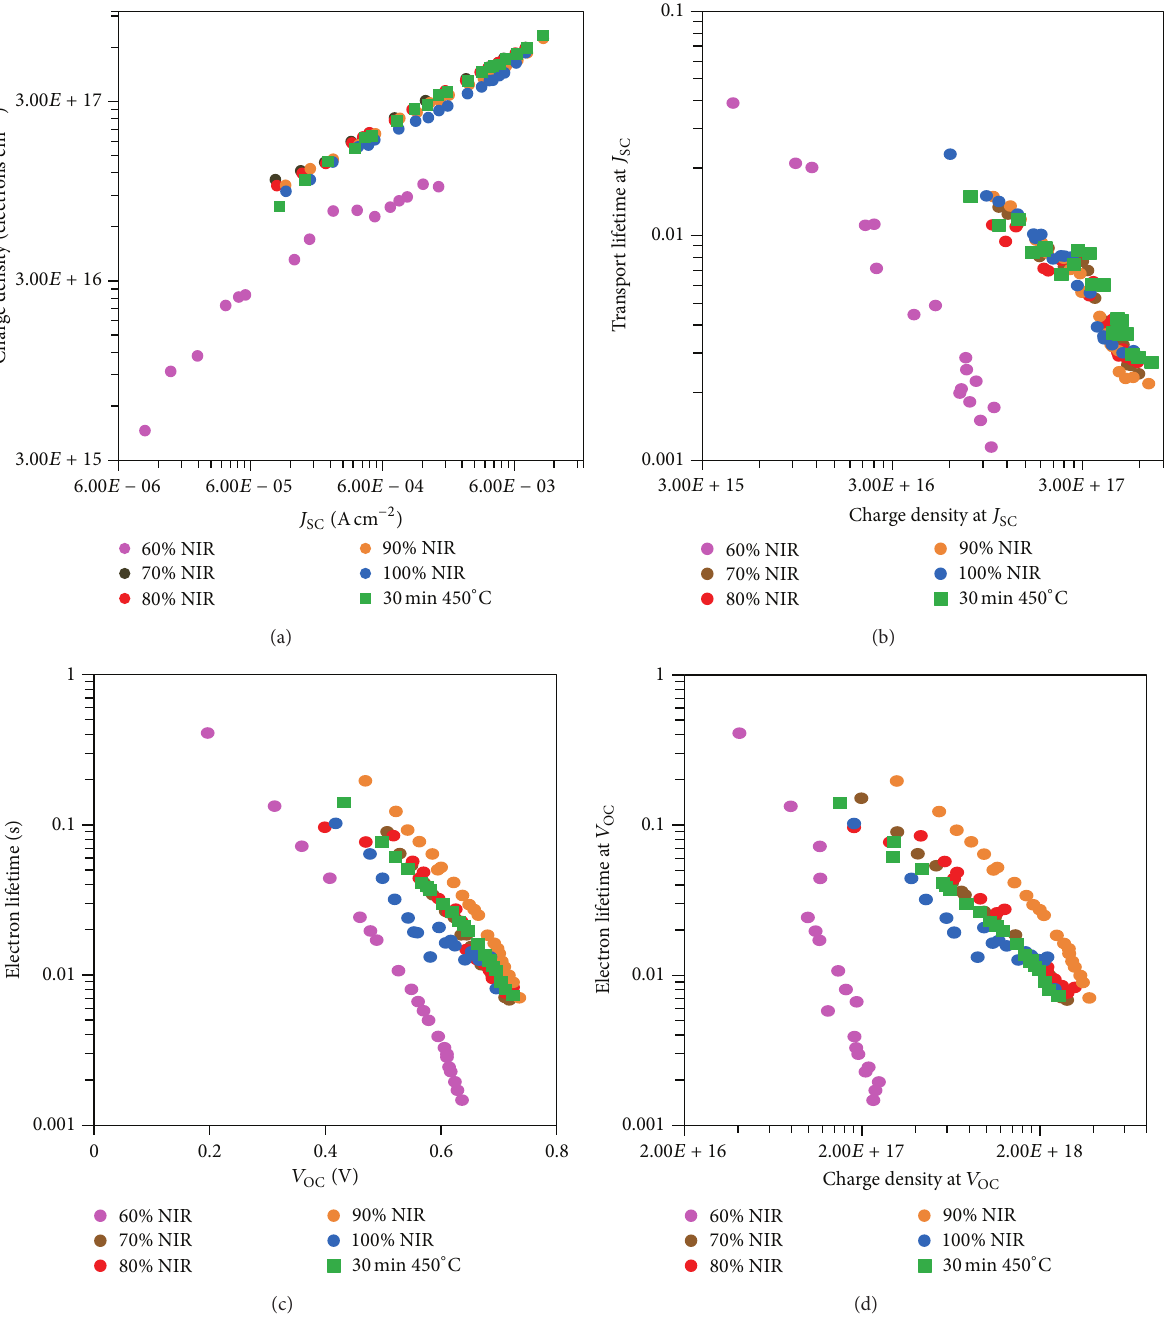
m, (b) transport lifetime versus charge density at 𝐽 SC . OC